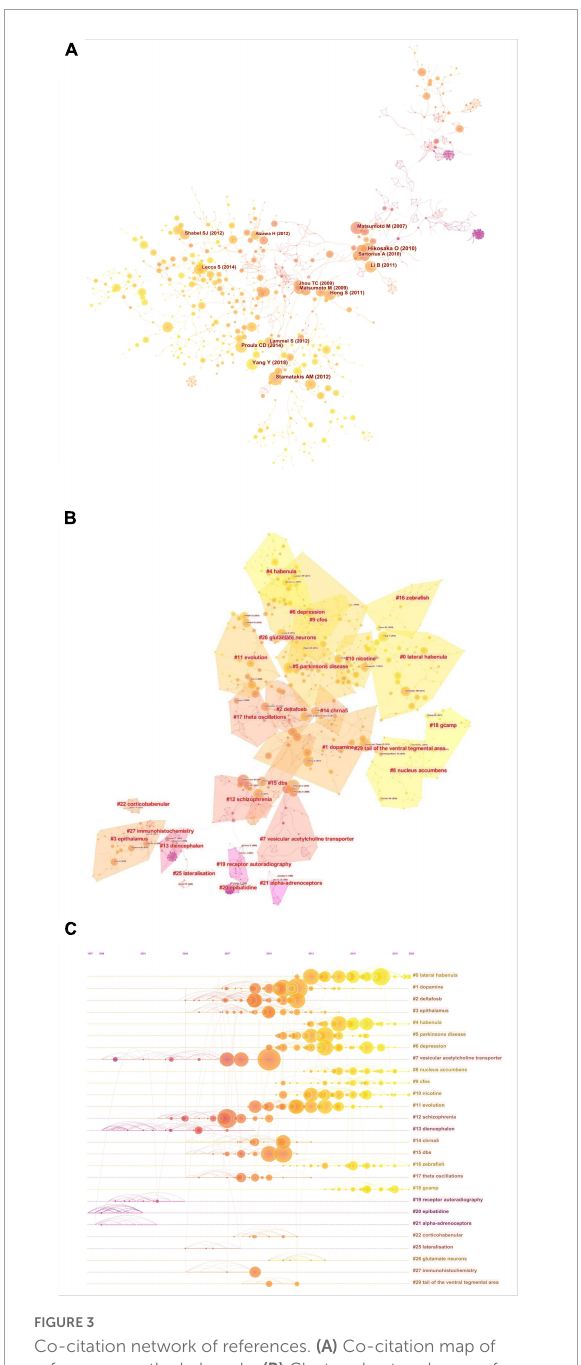
FIGURE3 Co-citation network of references. (A) Co-citation map of references on the habenula. (B) Clustered network map of co-cited references on the habenula. (C) Timeline view of co-citation clusters with cluster labels shown on the right.